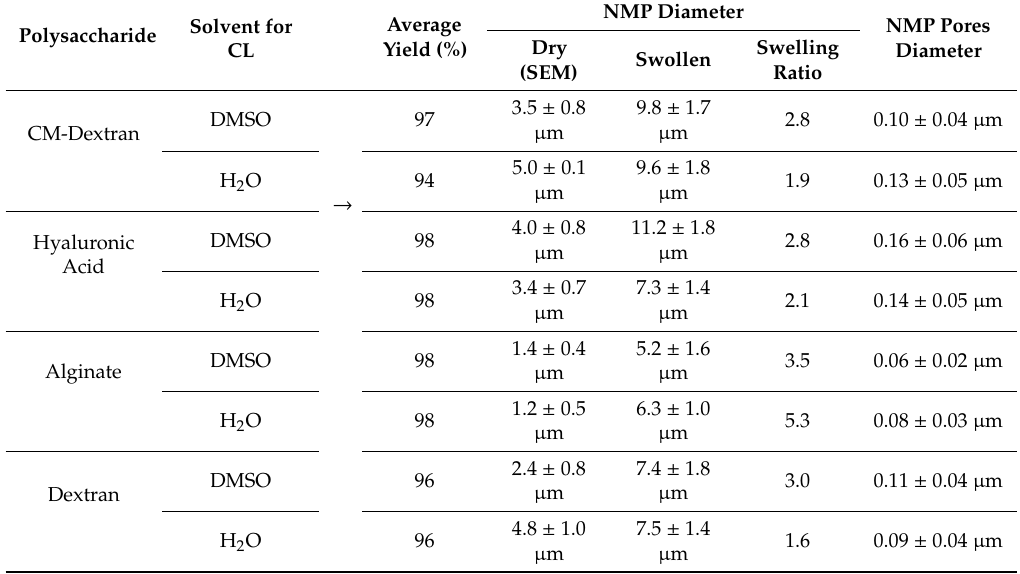
Table 2. A description of the reaction conditions of the 8 batches vs. yields and structural properties of NMP (diameter, pore size, swelling